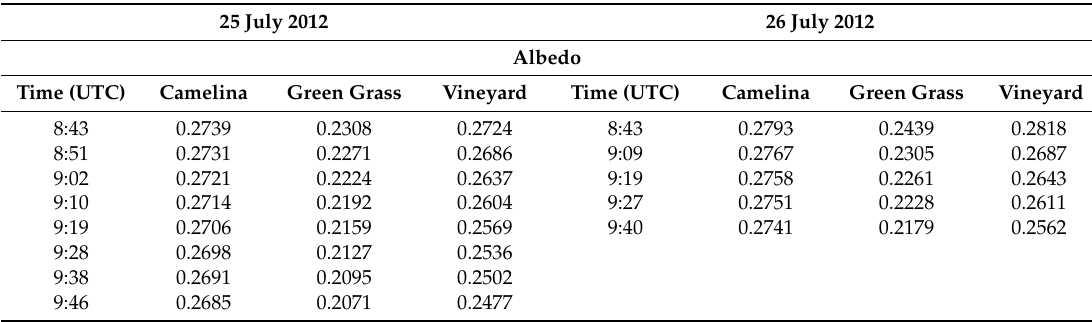
Table 3. Values of the field-measured albedo at the camelina site, the green grass site, and the vineyard site at the time of the flights. The albedo values are obtained using the equation of the albedo as a function of the